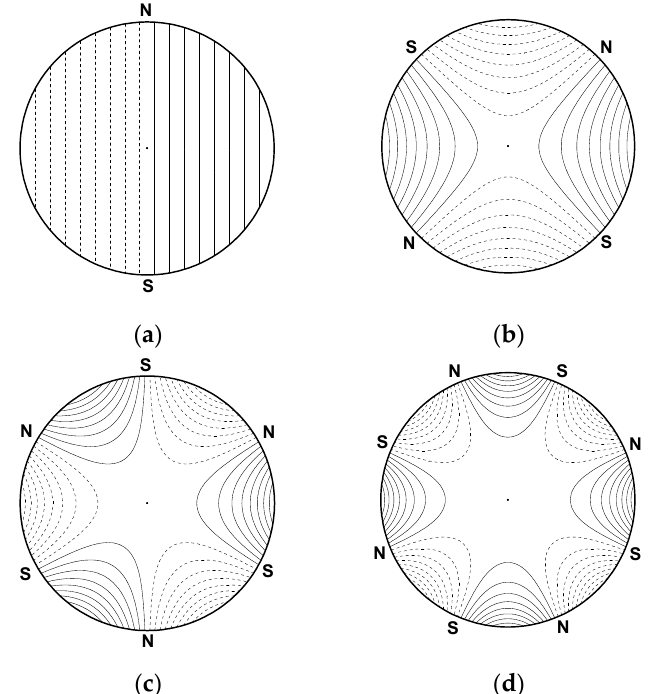
Figure 2. Magnetic field lines for four cases of number of pole-pairs. ( a ) m = 1; ( b ) m = 2; ( c ) m = 3; ( d ) m = 4. The solid and dotted lines are positive and negative values of A z respectively.